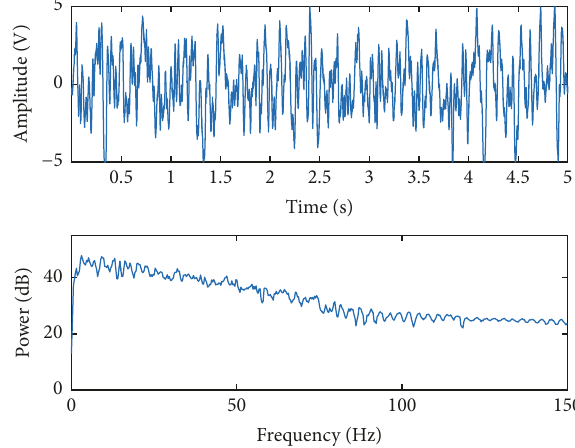
Figure 15: Flow meter value is 0.49 m/s when the transducer frequency is 25 Hz.